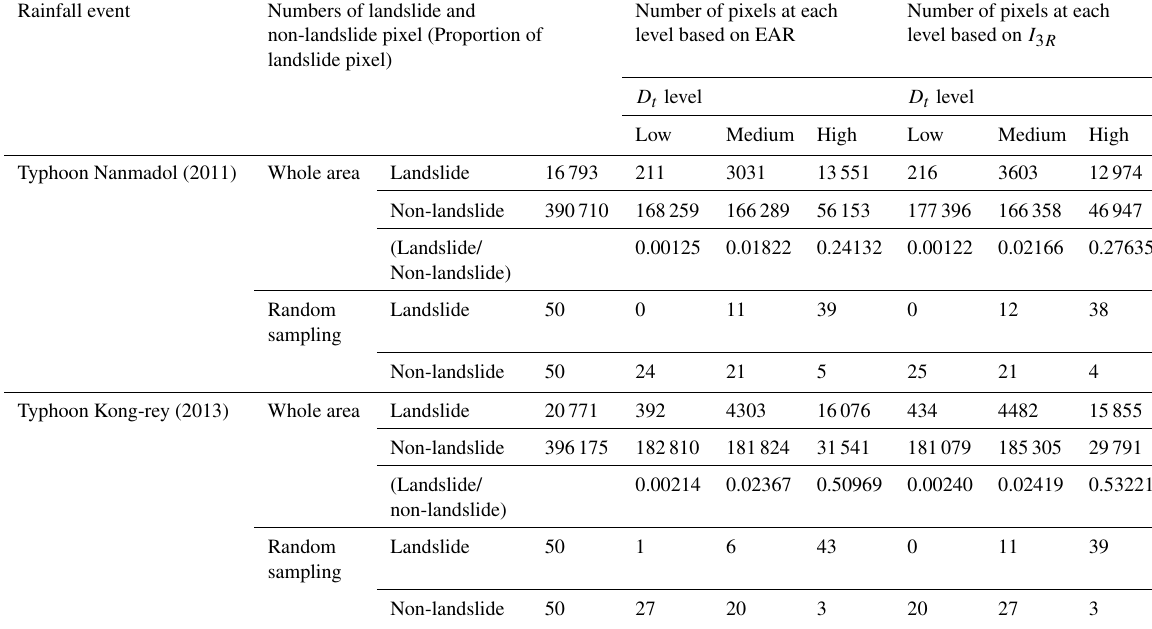
Table 9. Numbers of landslide pixels in the study correspond to different D t levels under different rainfall factors after typhoons. Number of pixels at each Rainfall event Numbers of landslide and non-landslide pixel (Proportion of level based on landslide pixel)